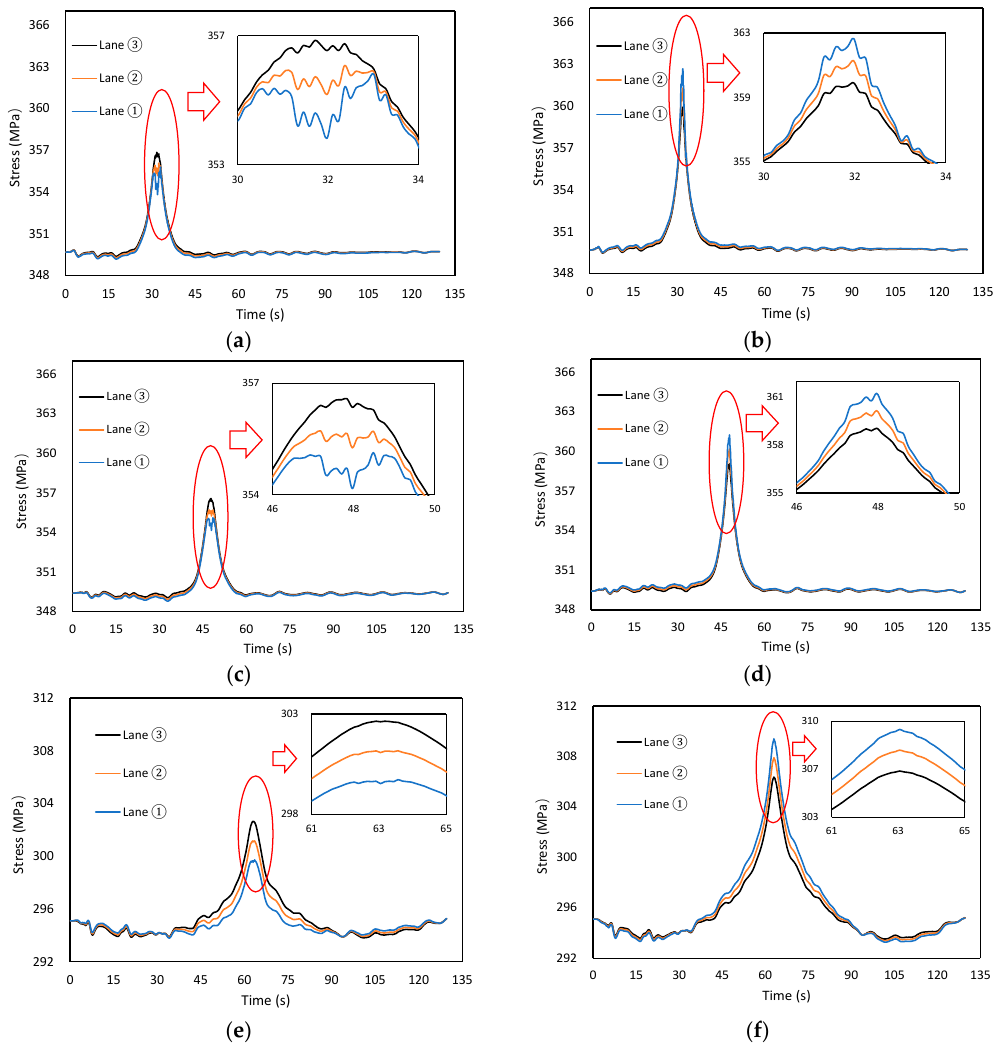
Figure 16. Time-dependent laws of suspender stress in di ff erent driving lanes. ( a ) Suspender A,